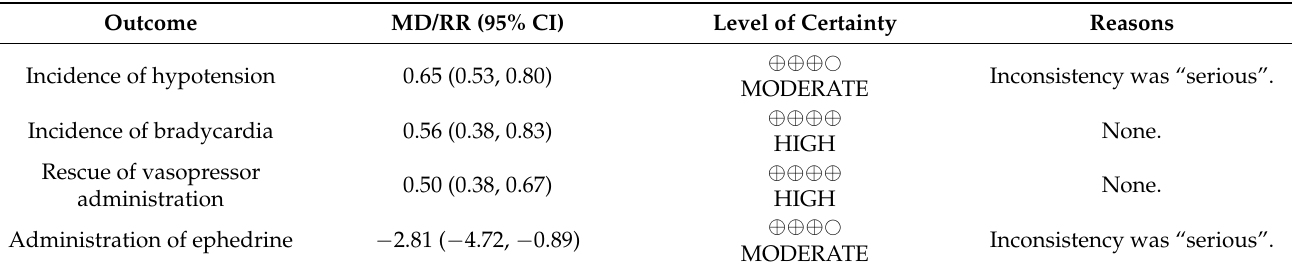
Table 2. The overall results of the GRADE